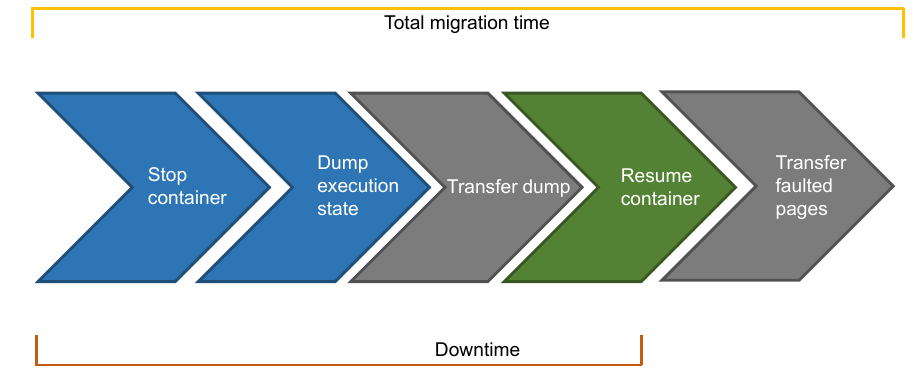
Figure 5. Post-copy migration.